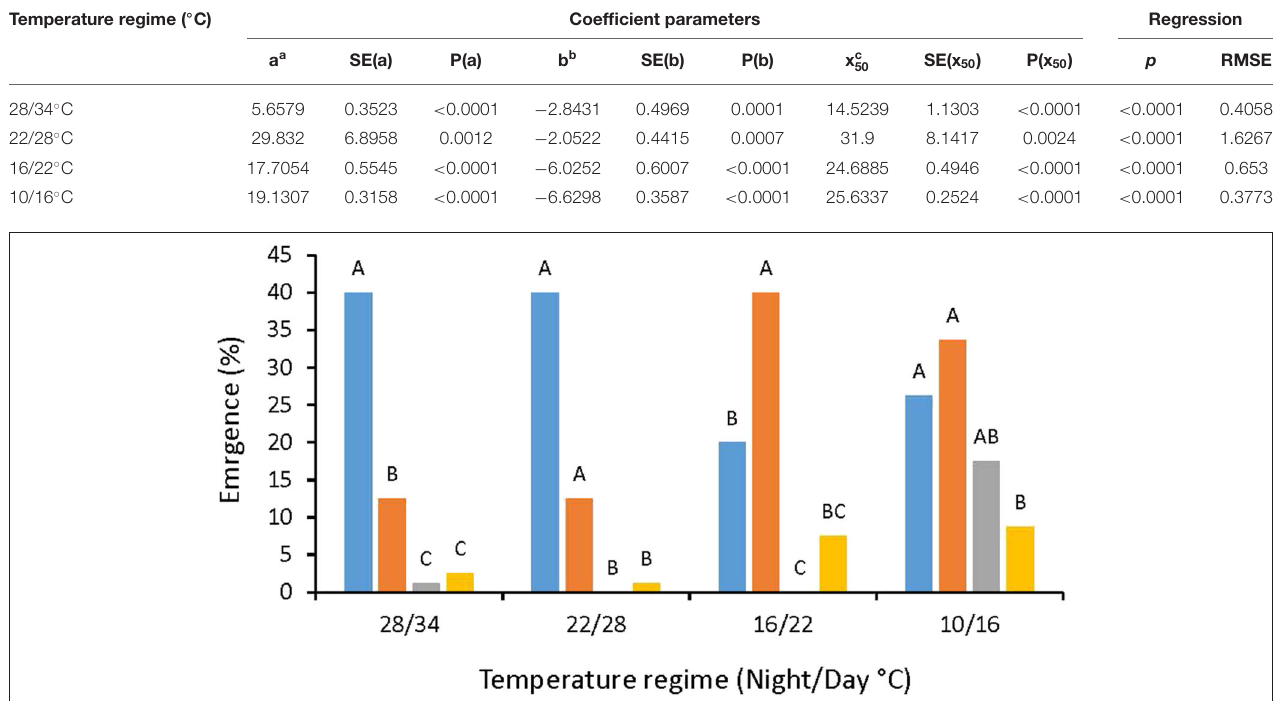
FIGURE 3 | A. artemisiifolia emergence rates at four temperature regimes, 55 DAS. Columns within each temperature regime topped by different letters are significantly different according to Tukey-Kramer HSD, p = 0.05.